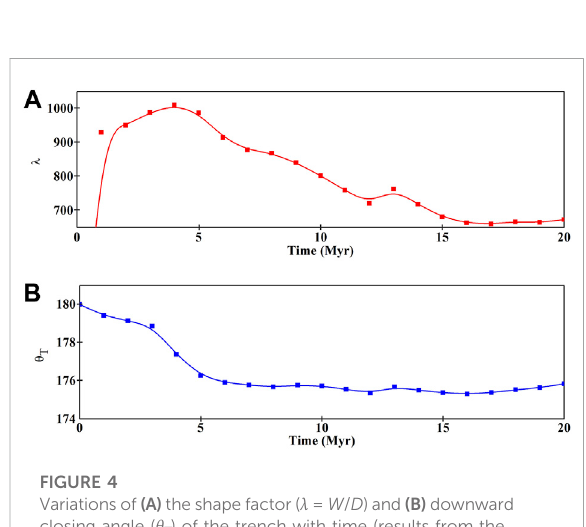
FIGURE 4 Variations of (A) theshapefactor( λ = W / D )and (B) downward closing angle ( θ T ) of the trench with time (results from the reference